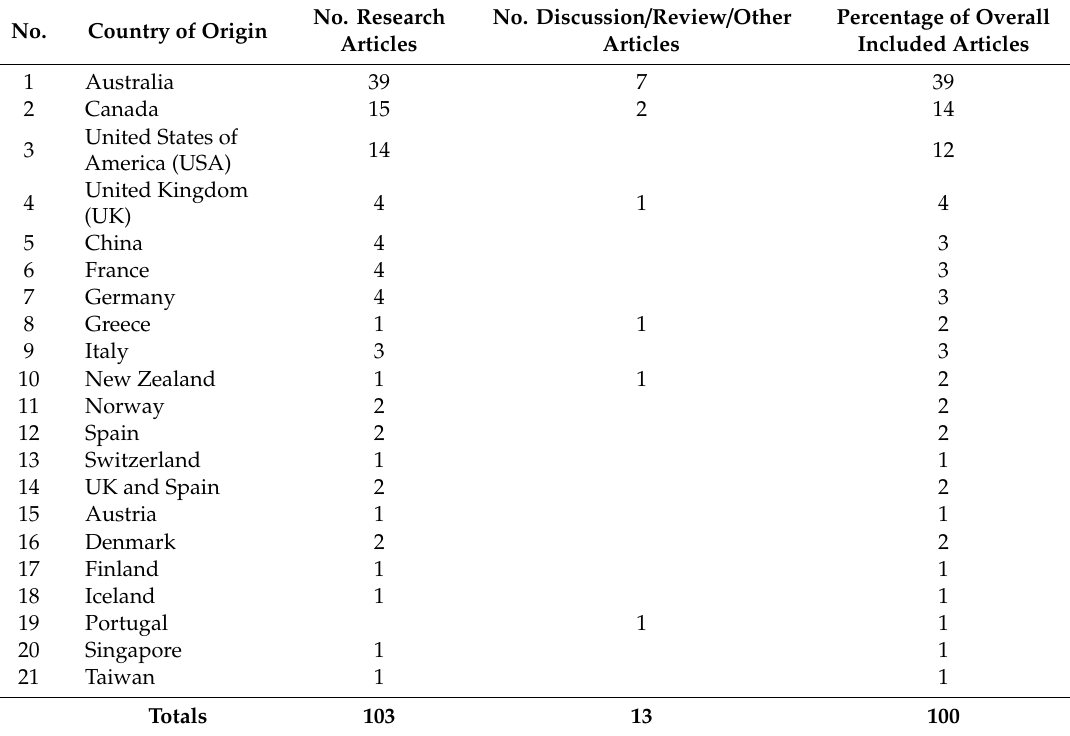
Table 3. Country of origin for included